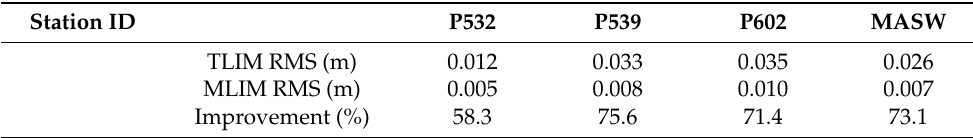
Table 2. The mean RMS errors and improvement percentage of the interpolated DD tropospheric delay using the TLIM and MLIM at each rover station in Dataset Two.